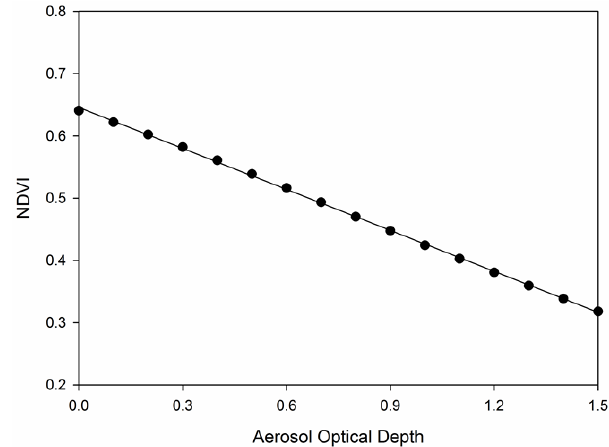
Figure 1. The Normalized Difference Vegetation Index (NDVI) at the reflectance at the top of the atmosphere (TOA) as a function of the Aerosol Optical Depth (AOD) at 550 nm, demonstrating that the NDVI is strongly influenced by aerosols.